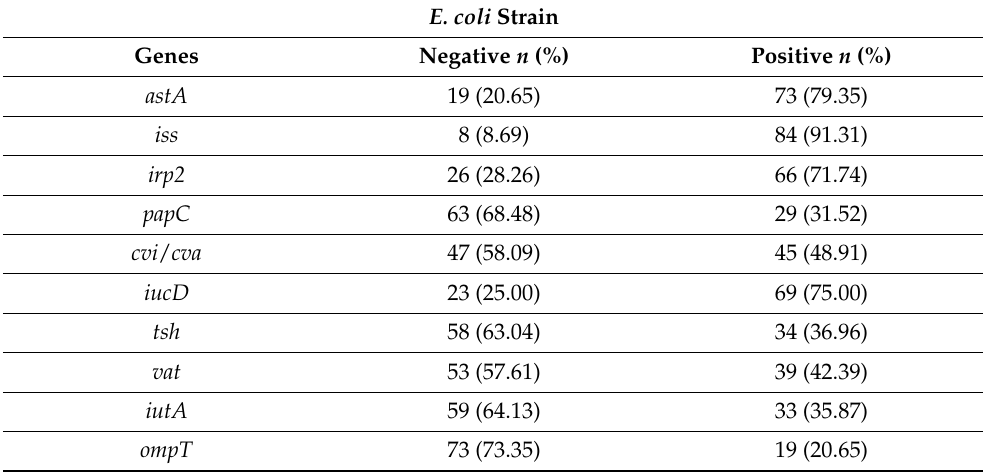
Table 1. Distribution of virulence genes in APEC and non-APEC strains.